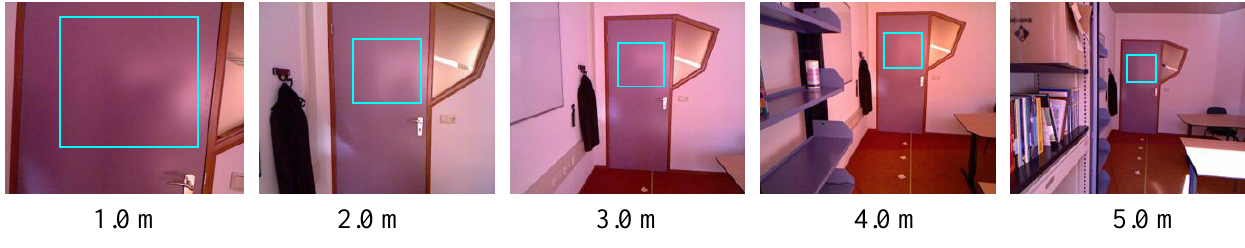
Figure 9. The planar surface of a door measured at different distances to the sensor. The boxes show the plane fitting